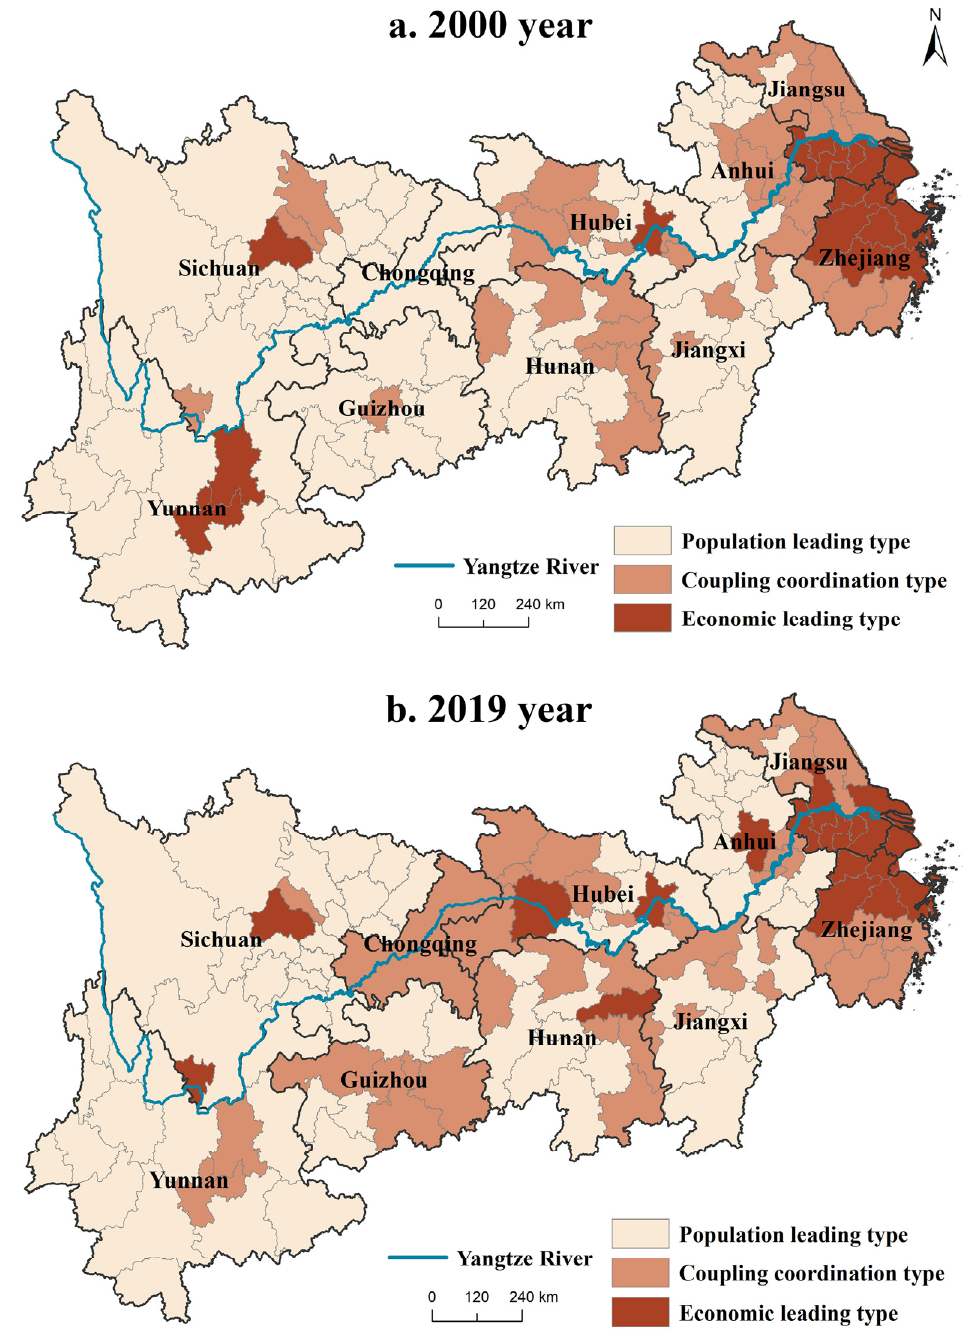
Figure 7. The degree of coordination between population and economy in 2000 and 2019.